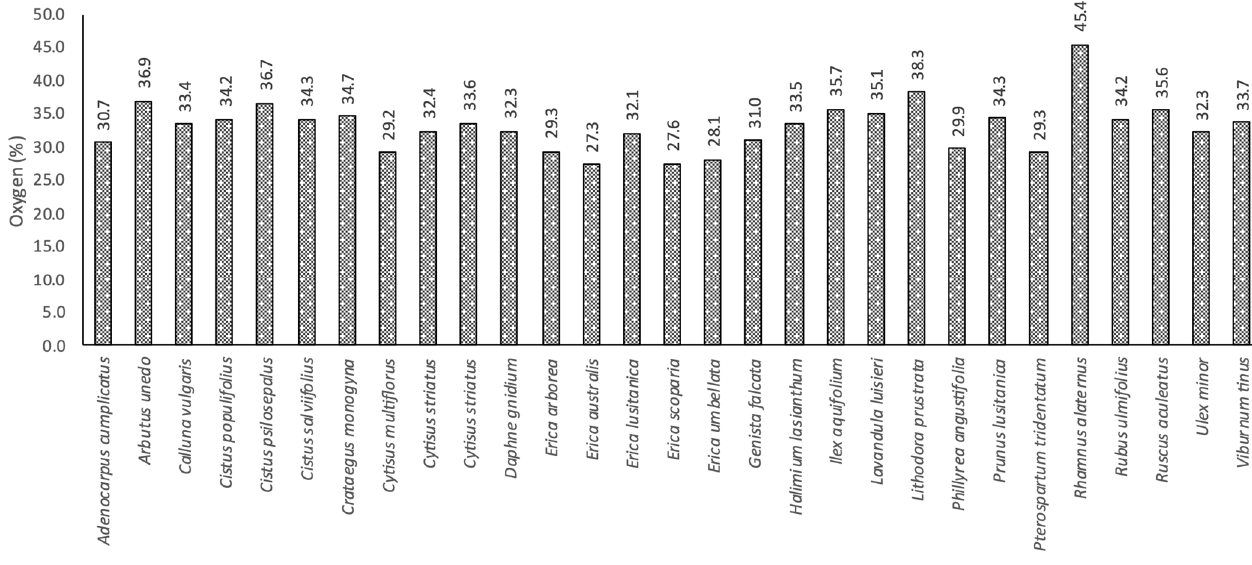
Figure 8. Oxygen content (%) of the studied species.